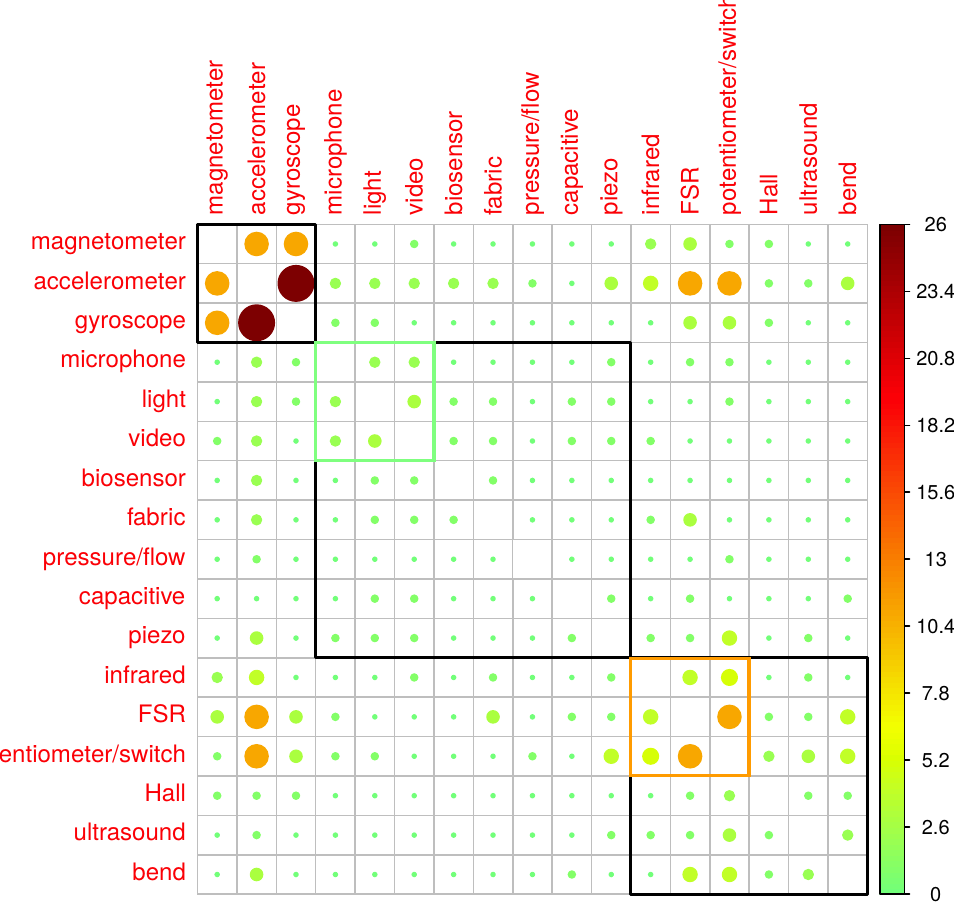
Figure 4. Co-occurrence matrix map plus Ward hierarchical clustering for 3 clusters. As the co-occurrences of an aspect with itself were shown in Table 1, the main diagonal is blank for clarity. Upper and lower matrices report the same information. The green and orange squares present the 4 clusters